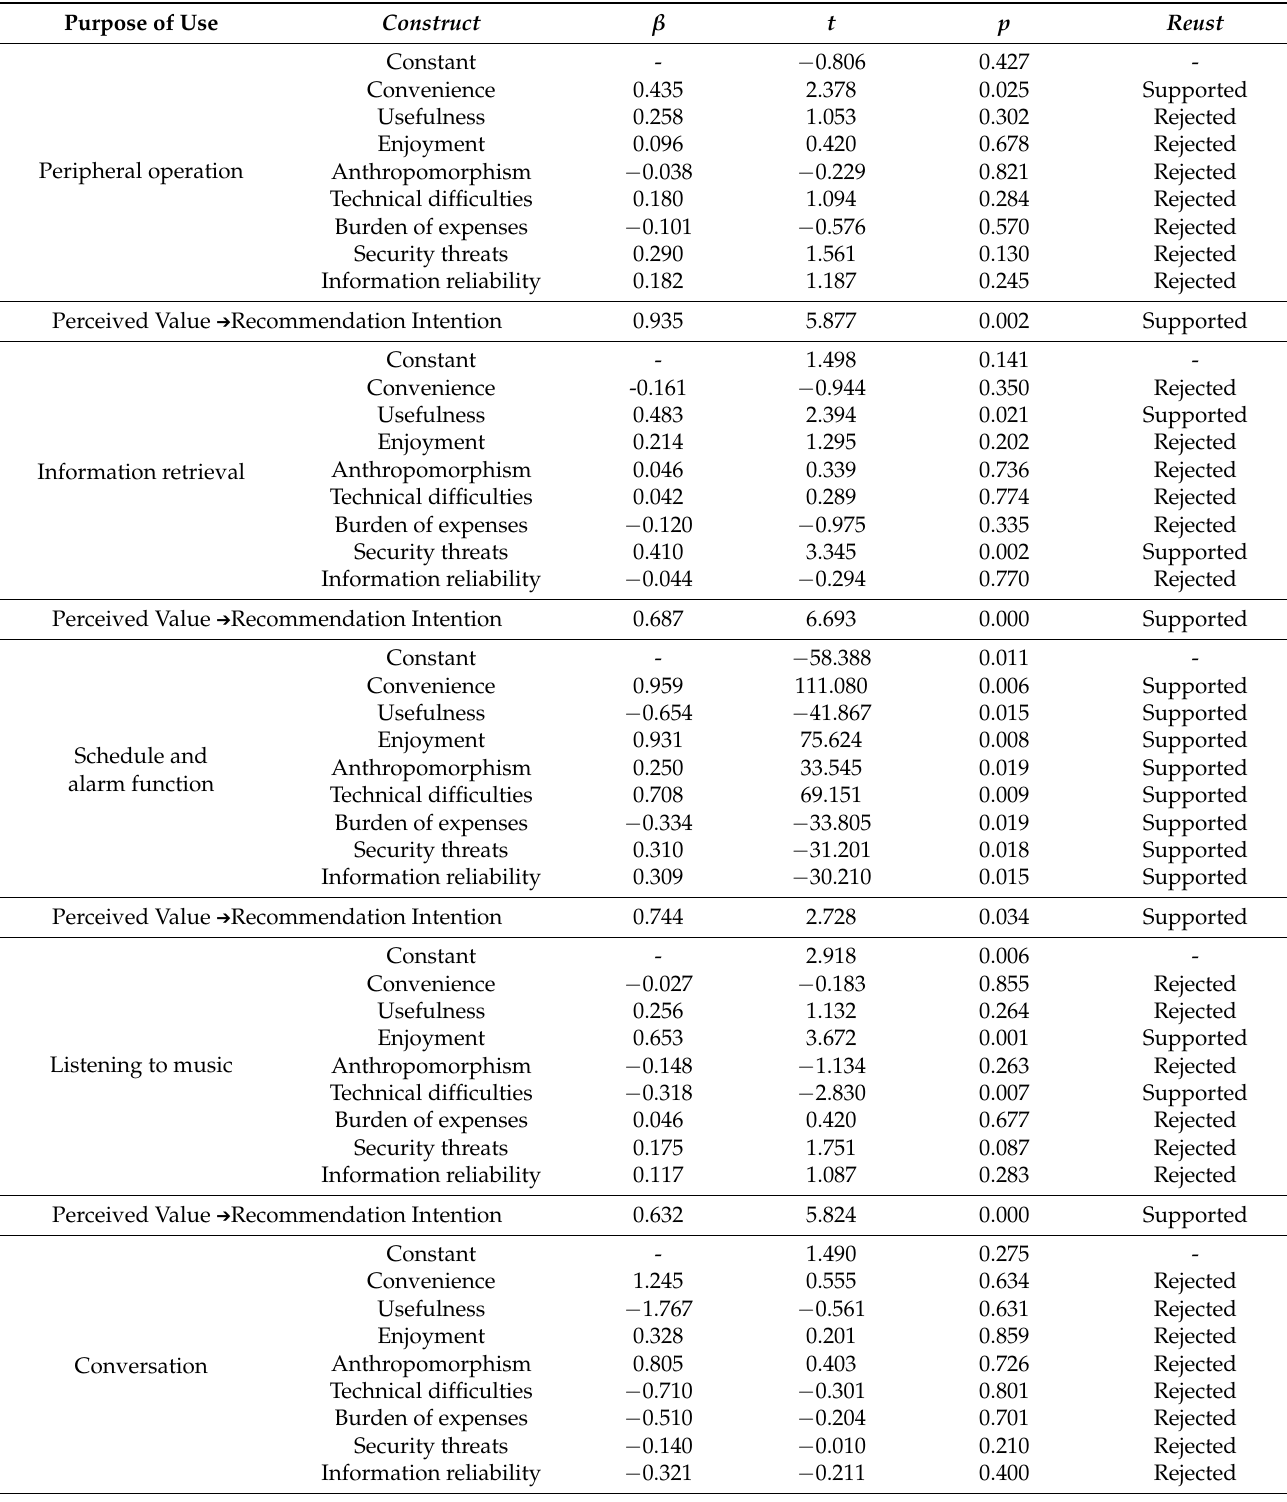
Table 8. Causal relationship analysis according to the purpose of